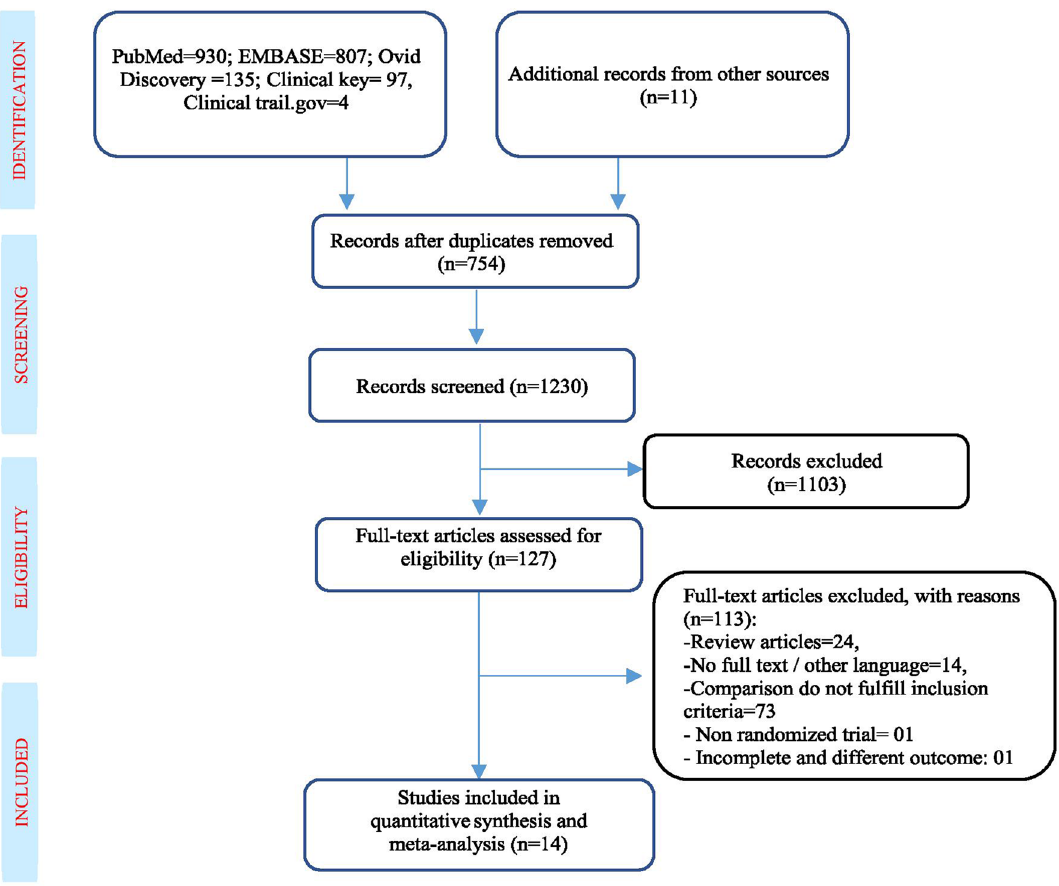
Figure 1. PRISMA flow diagram. From: Moher D, Liberati A, Tetzlaff J, Altman DG, The PRISMA Group (2009) Preferred Reporting Items for Systematic Reviews and Meta-Analyses: The PRISMA Statement. PLoS Med 6(7): e1000097. https ://doi.org/10.1371/journ al.pmed.10000 97